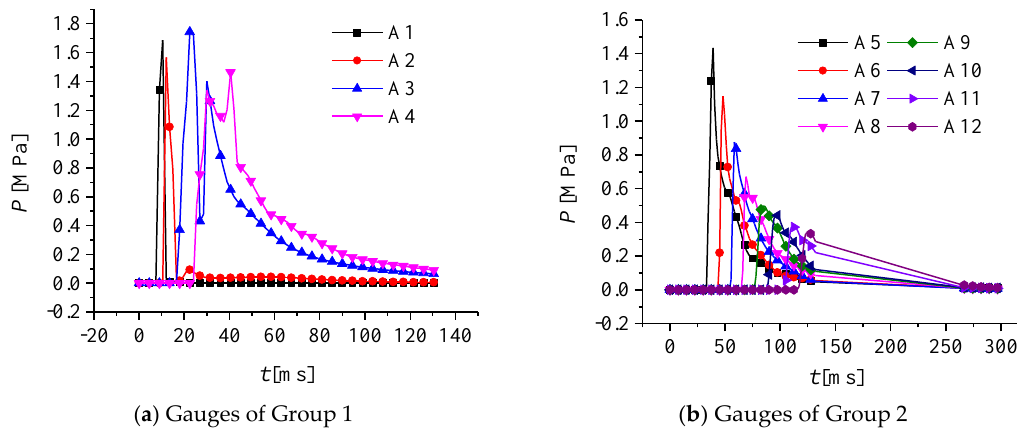
Figure 10. Pressure-time curves at 2 m gauges of shock wave above the soil ground.